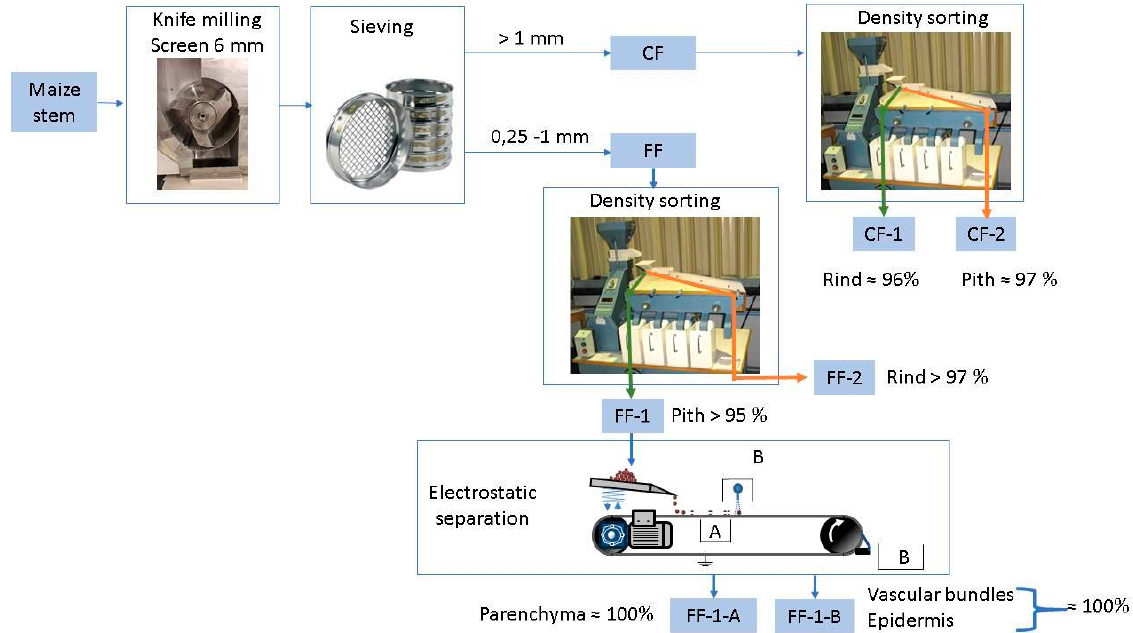
Figure 1. Process flow diagram for sorting the pith-dense fraction (FF-1-A and CF-1), rind-dense fraction (FF-2 and CF-2), and vascular bundles (FF-1-B).